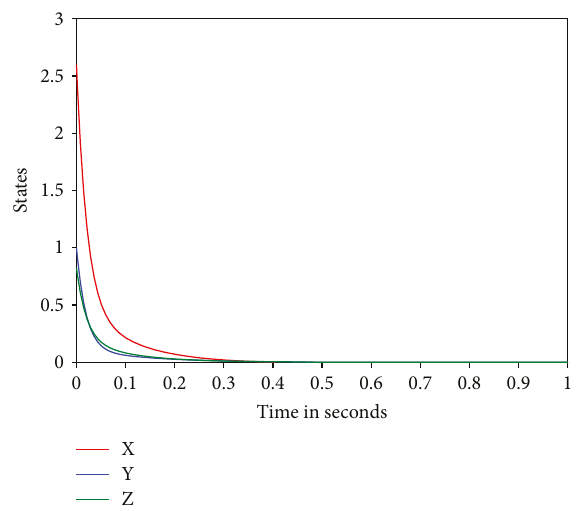
Figure 5: Time history of the states with control in action at t = 35 s .